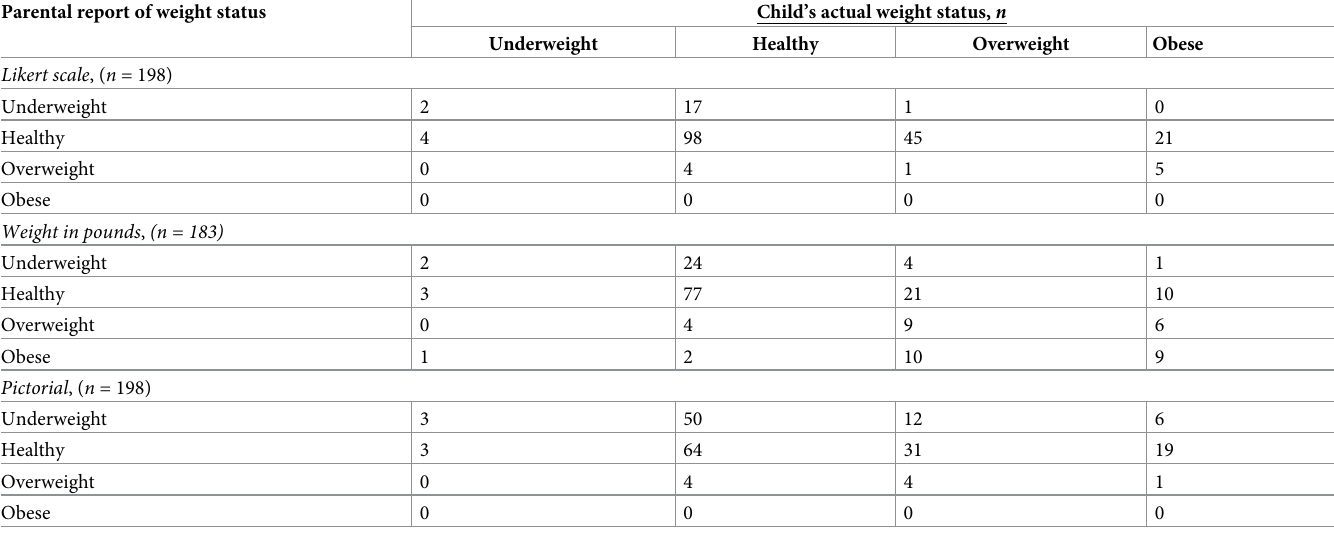
Table 3. The agreement between parent’s descriptions of the child’s perceived weight status and the child’s actual weight status based on CDC guidelines at age 2 to 5.